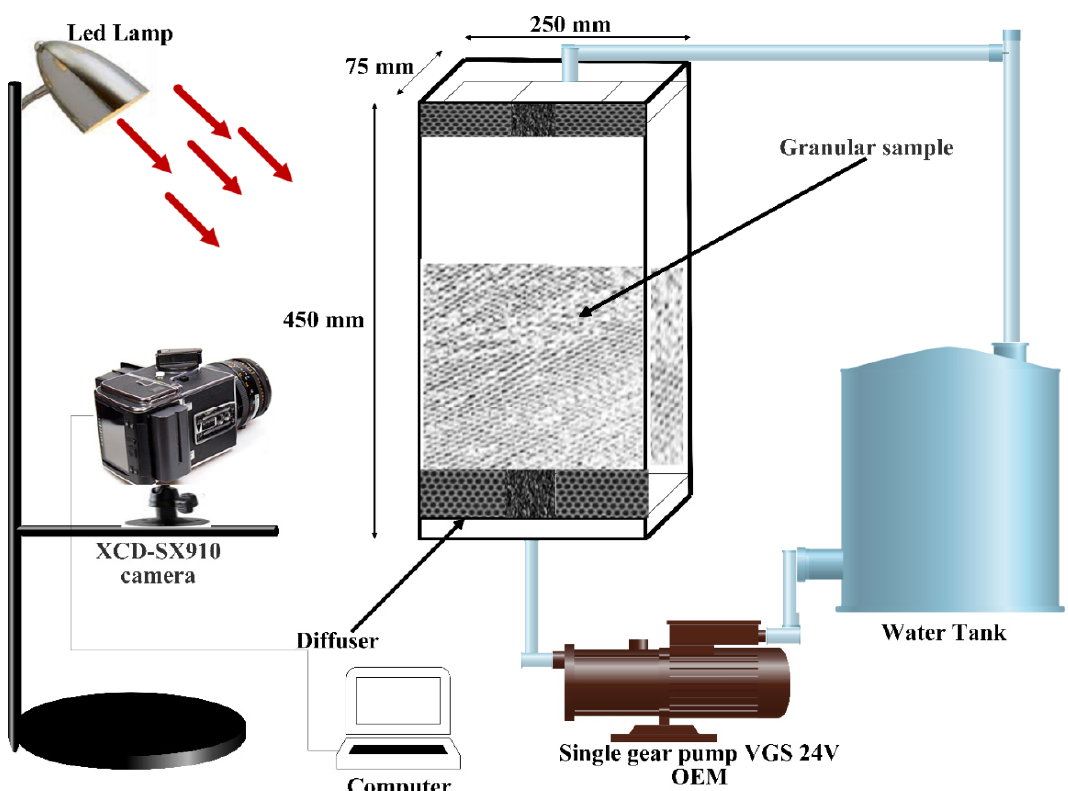
Figure 1. Schematic representation of the experimental device.